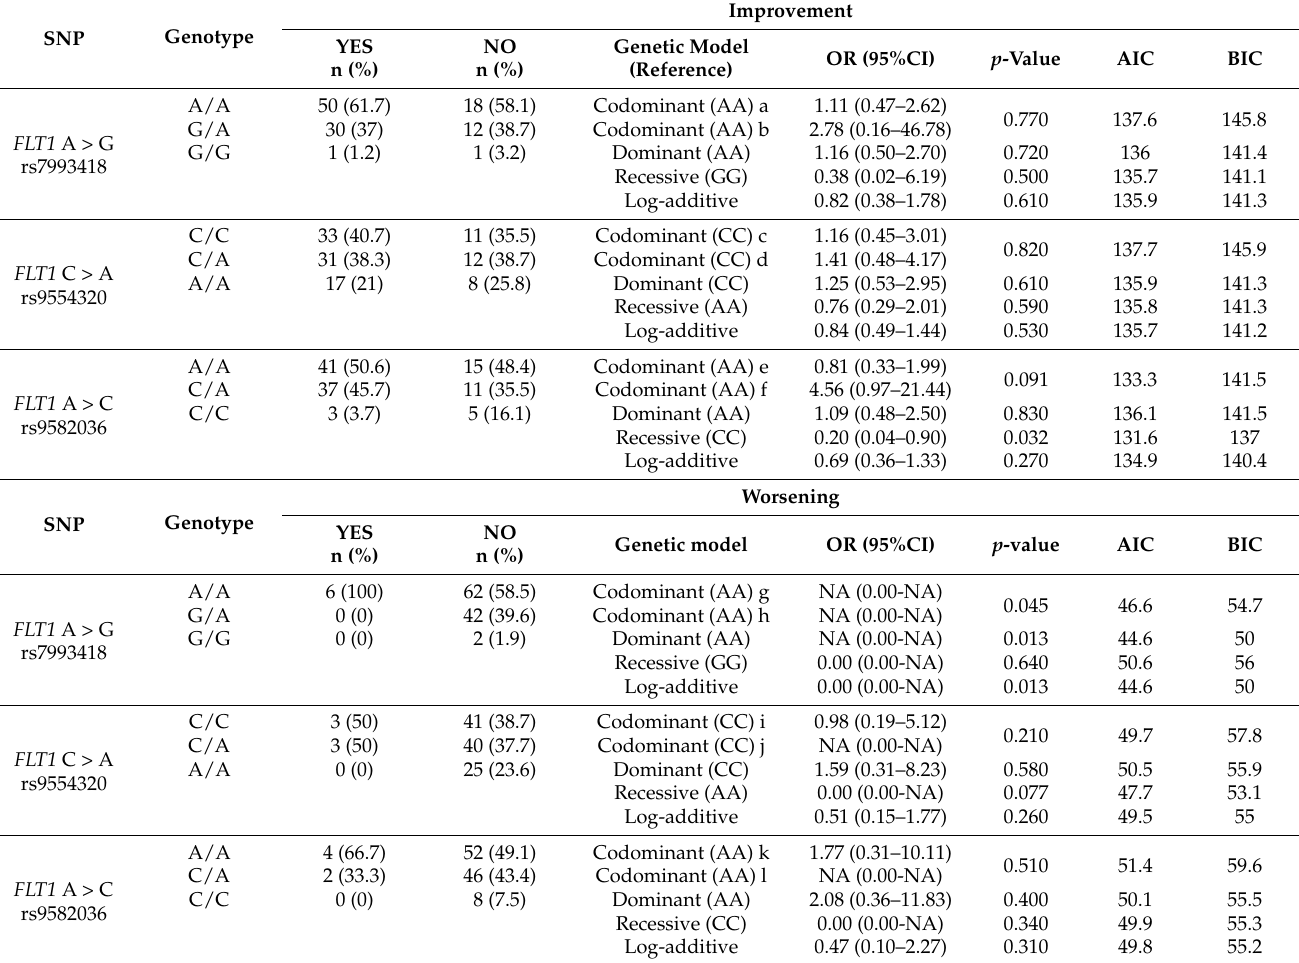
Table 3. Association study of FLT1 genotypes with BCVA improvement/worsening at 12